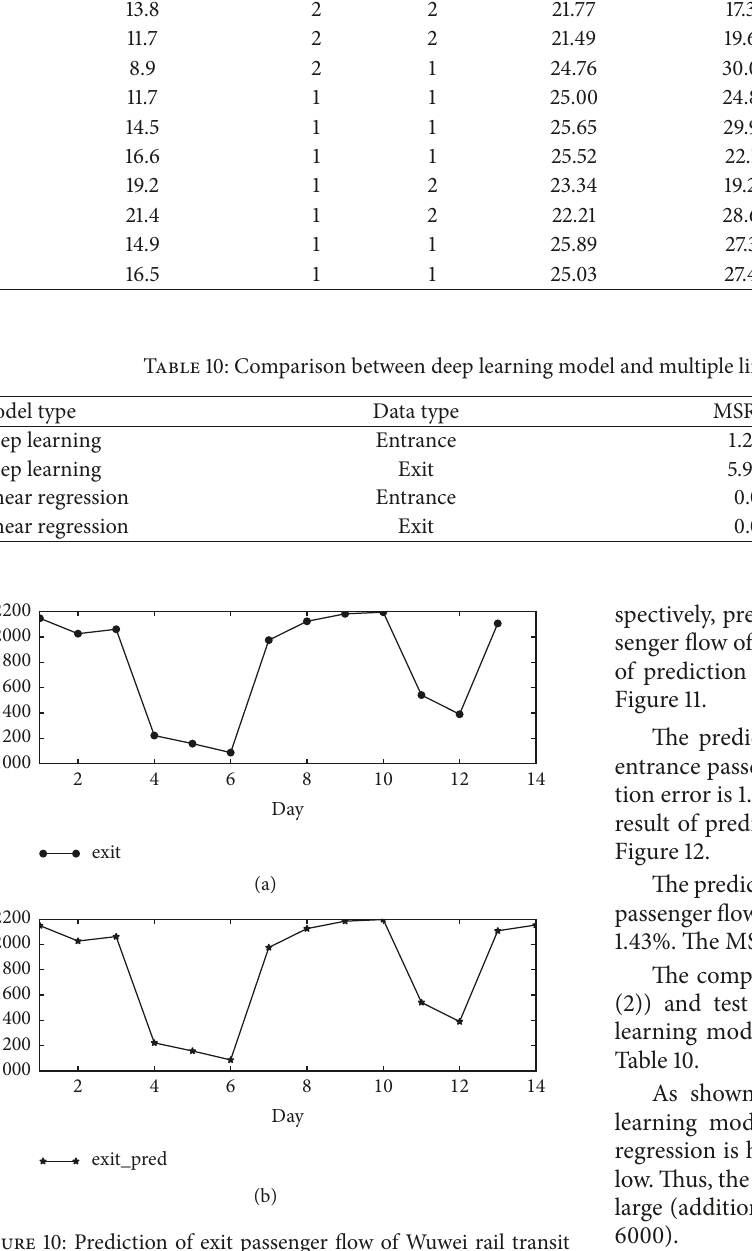
Figure 10: Prediction of exit passenger flow of Wuwei rail transit station at Day